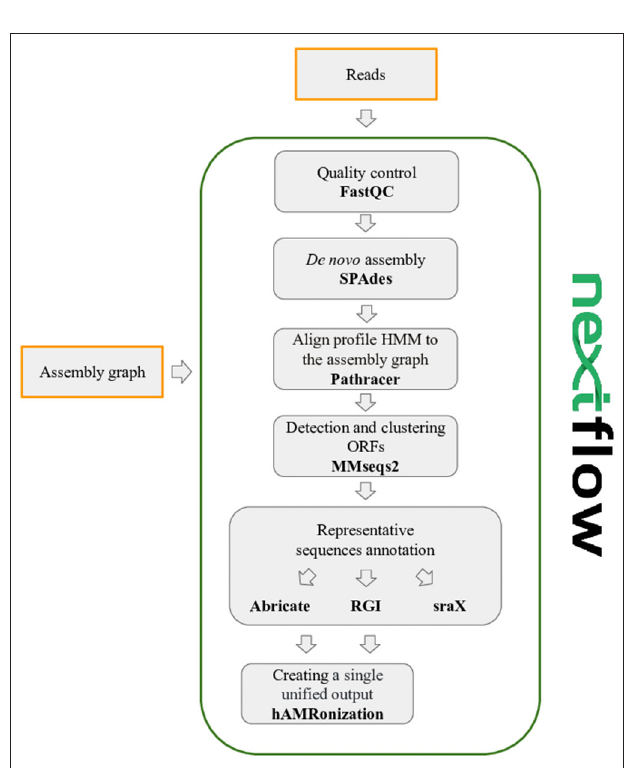
FIGURE 5 | General GraphAMR pipeline